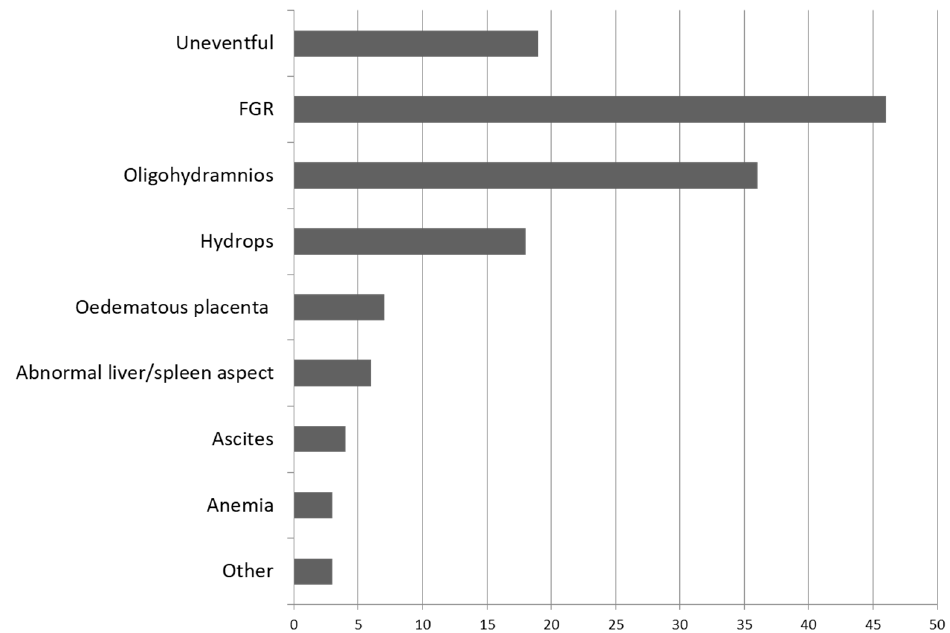
Figure 2. Prenatal findings in 74 cases evaluated in the literature review diagnosed with neonatal hemochromatosis and with confirmed extrahepatic siderosis, reported from 1993 to 2021. Most fetuses had an inauspicious prognosis, with the pregnancies ending in fetal death, perinatal death, or therapeutic interruption of pregnancy. Favorable evolution